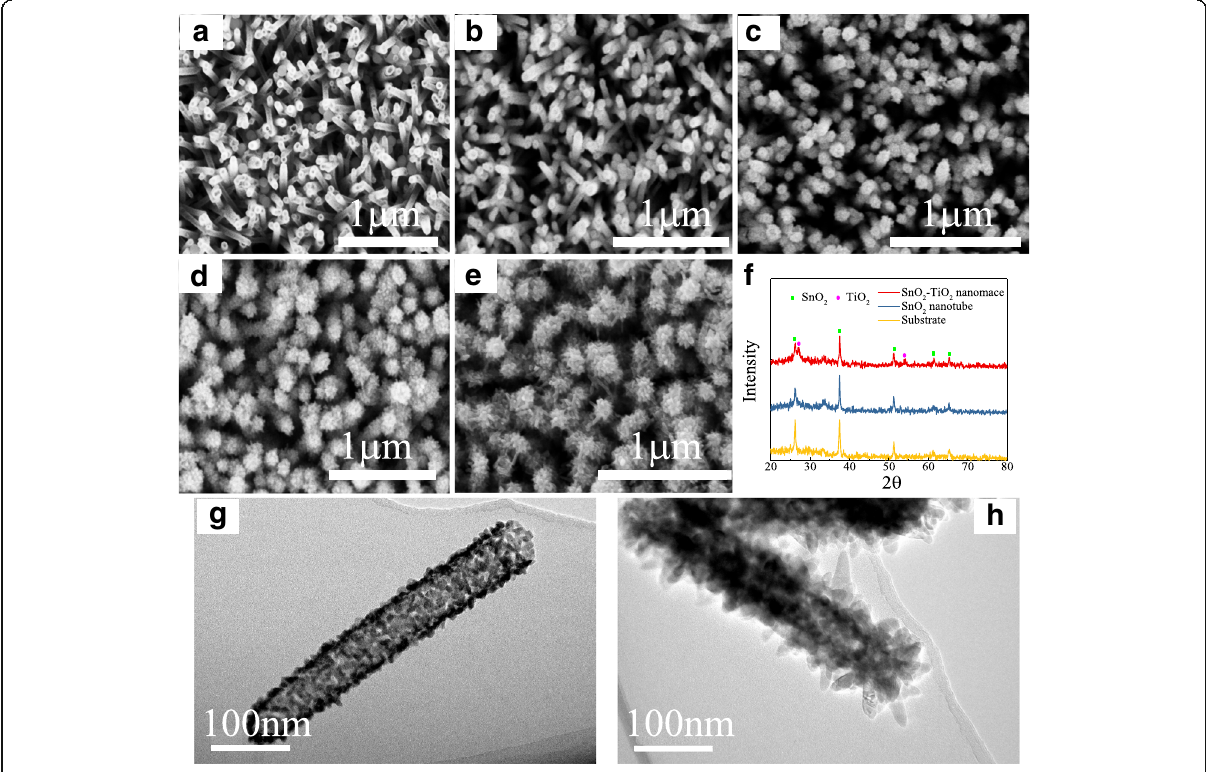
Fig. 2 SEM and TEM images and XRD patterns of SnO 2 nanotube arrays and SnO 2 -TiO 2 nanomace arrays. a High-magnification top-view SEM image of SnO 2 nanotube arrays. b SEM image of 6-h-grown STNMAs. c SEM image of 12-h-grown STNMAs. d SEM image of 18-h-grown STNMAs. e SEM image of 24-h-grown STNMAs. f X-ray diffraction patterns of the substrate, SnO 2 nanotube arrays, and STNMAs. g TEM image of bare SNA. h TEM image of 18-h-grown